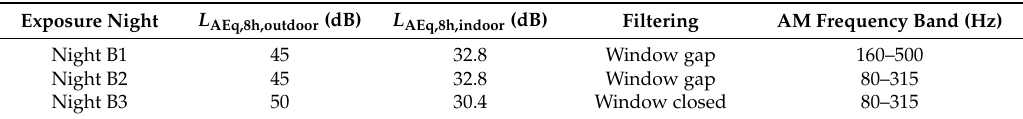
Table 3. Outdoor and indoor sound pressure levels, frequency filtering and AM frequency bands used in exposure Nights B1, B2 and B3 in Study